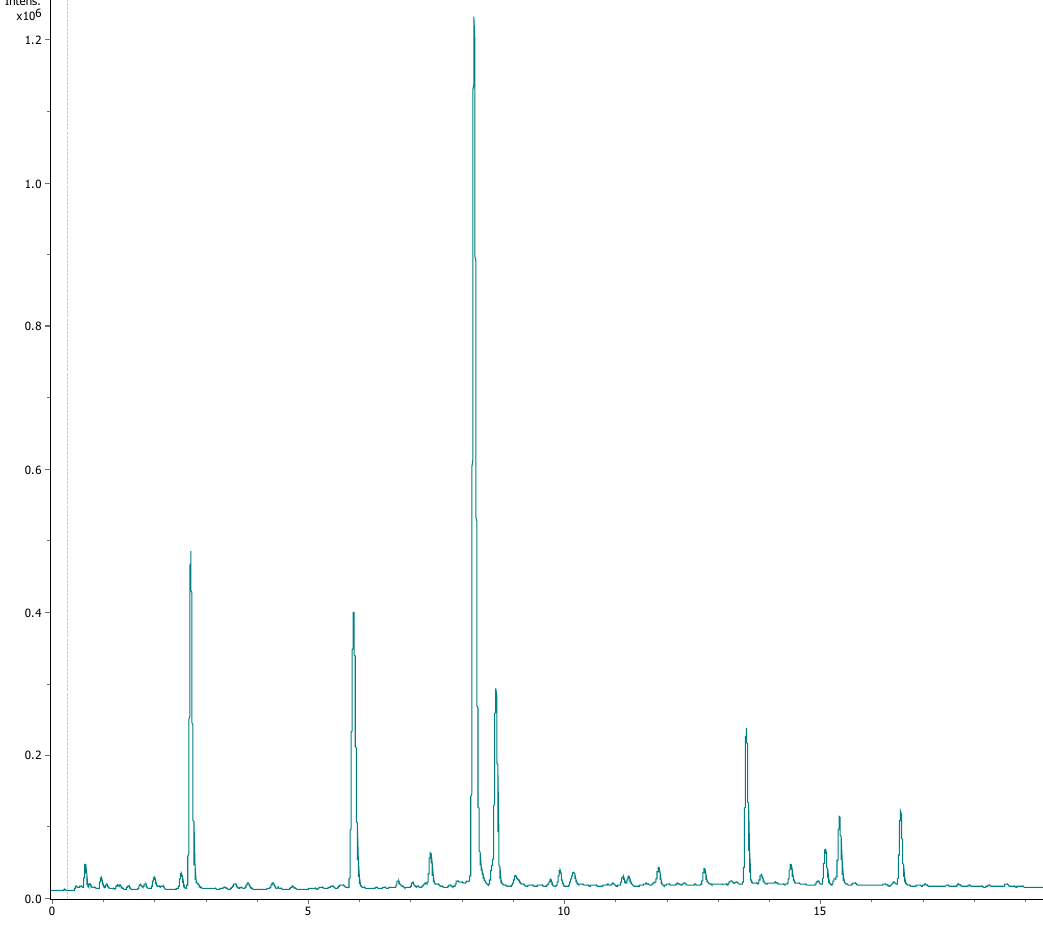
Figure A3. Ilex aquifolium L. leaves water extract, UV chromatogram, 280 nm.